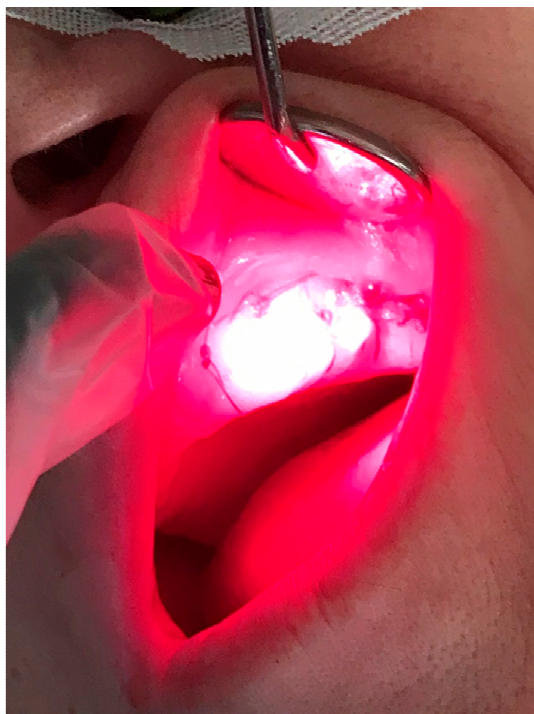
Figure 5. PBM therapeutic support. Laser application after the surgical removal of the necrotic bone fragment and the application of the L-PRF membrane.